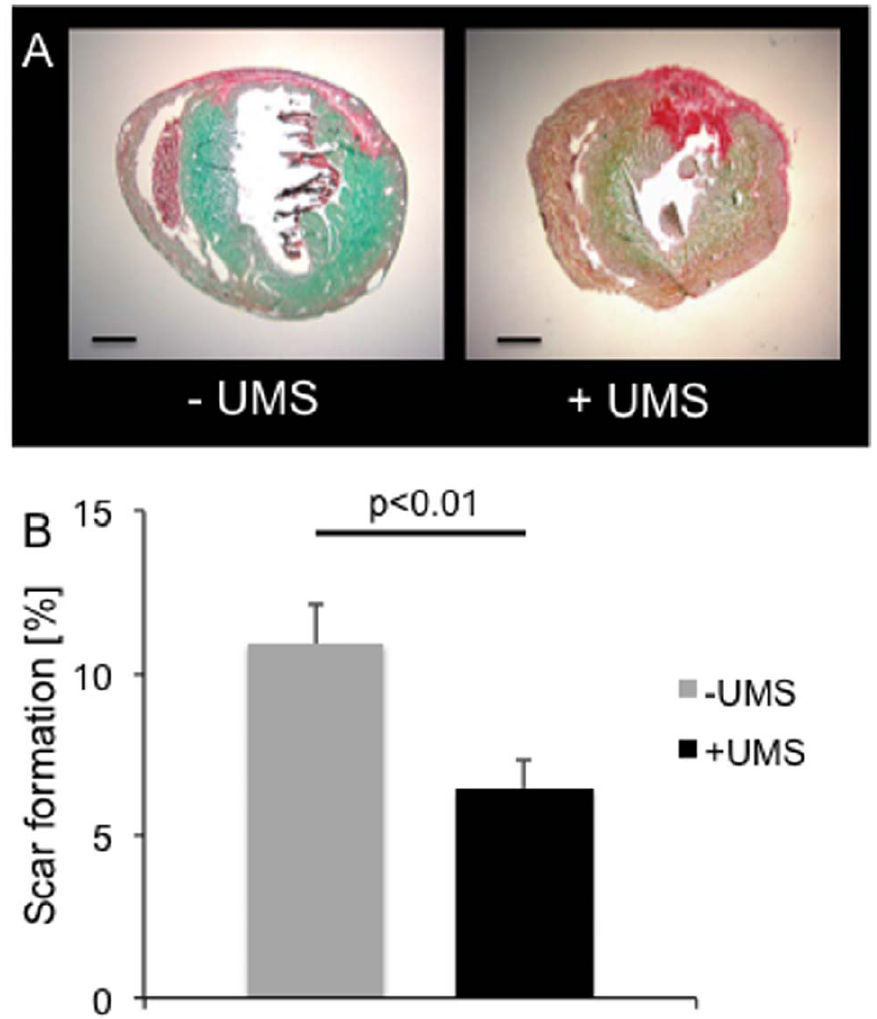
Figure 5. Histological analyses. Myocardial scar formation was determined by means of histomorphometry. (A) Representative images of short axis mouse heart sections stained with picrosirius-red and fast-green without (left) and with (right) UMS-treatment. The collagenous tissue is coloured red whereas myocardium is green. (B) UMS-treated mice demonstrated a significantly lower collagenous scar burden compared to control mice. three primers: 1. vascular-endothelial growth factor-a (VEGF-a), 2. insulin-like growth factor-1 (IGF-1) and 3. caveolin-3 (Cav-3)